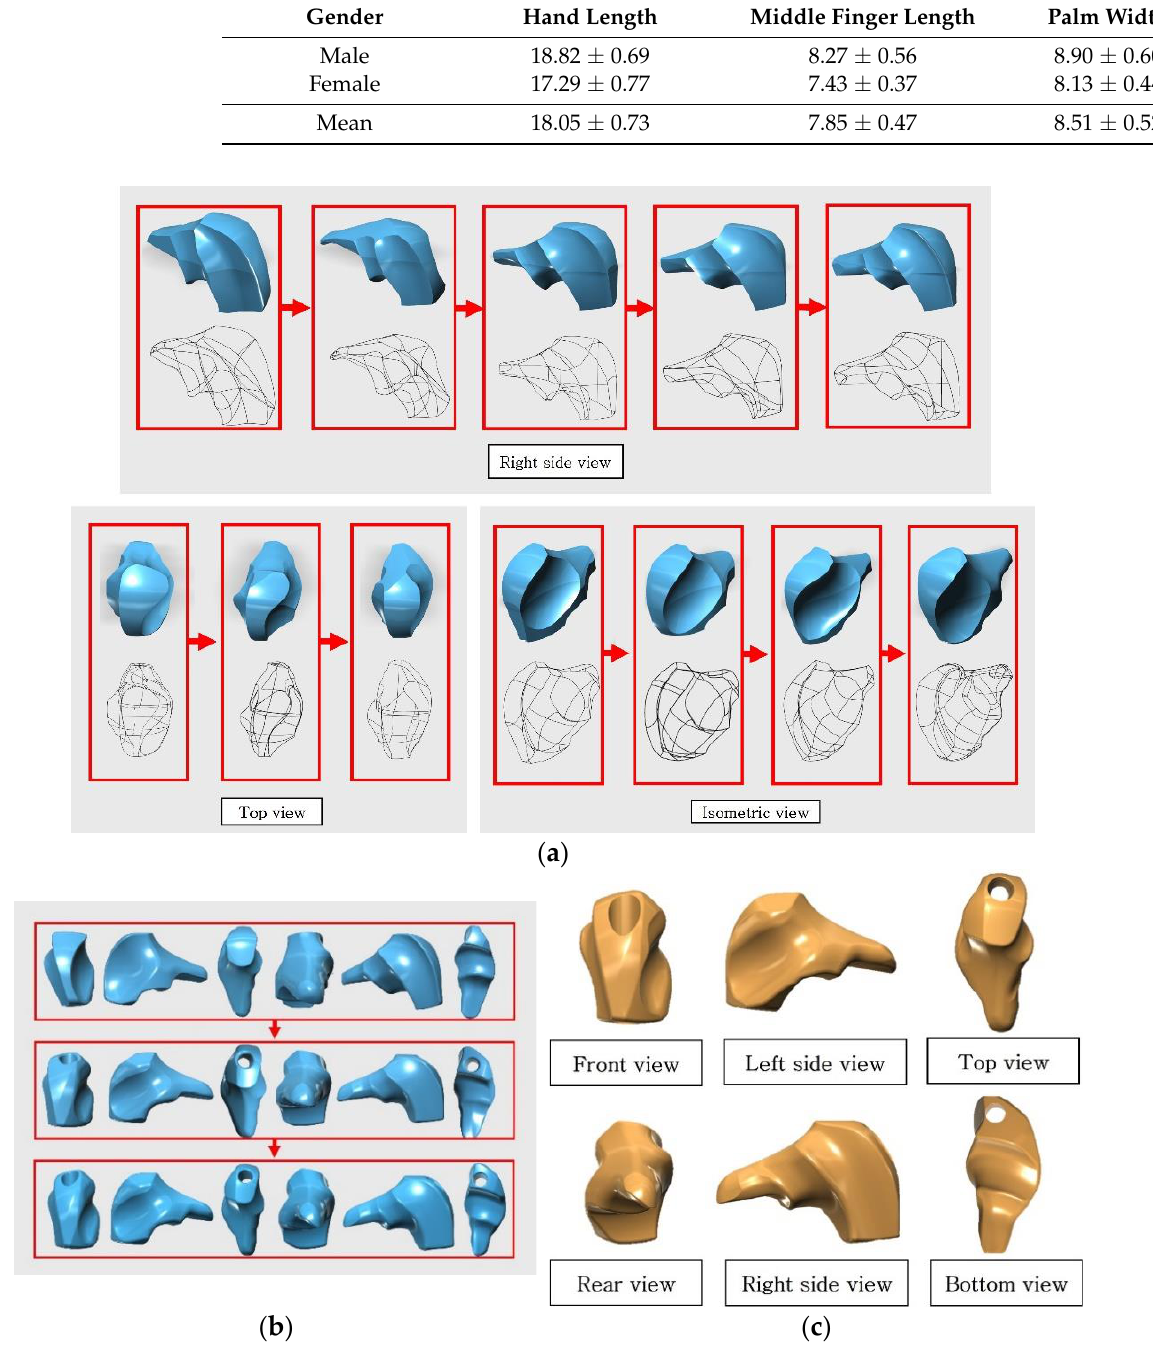
Figure 2. 3D modeling in the NDWAD: ( a ) initial design stage; ( b ) detail correction stage; and ( c ) final stage.